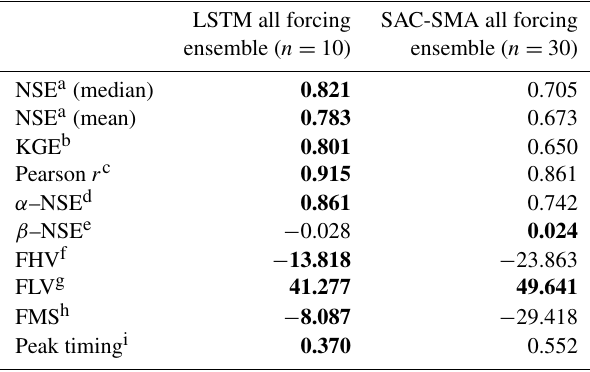
Table 2. Values of the benchmarking metrics from Table 1. Bold values indicates the best model ( α < 0 . 05). Multiple bold values per row indicate no significant difference.